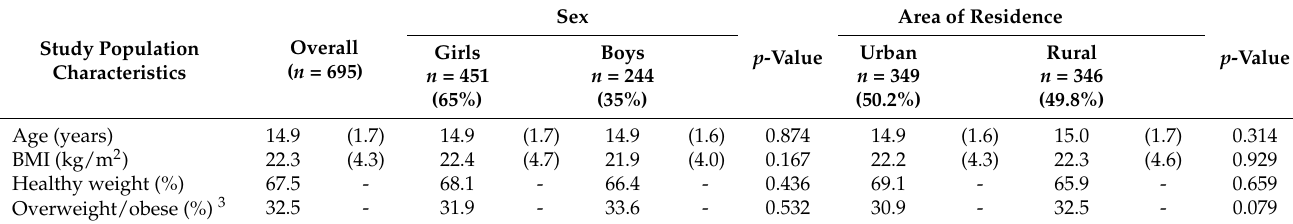
Table 1. General and weight characteristics of the study population 1,2 .